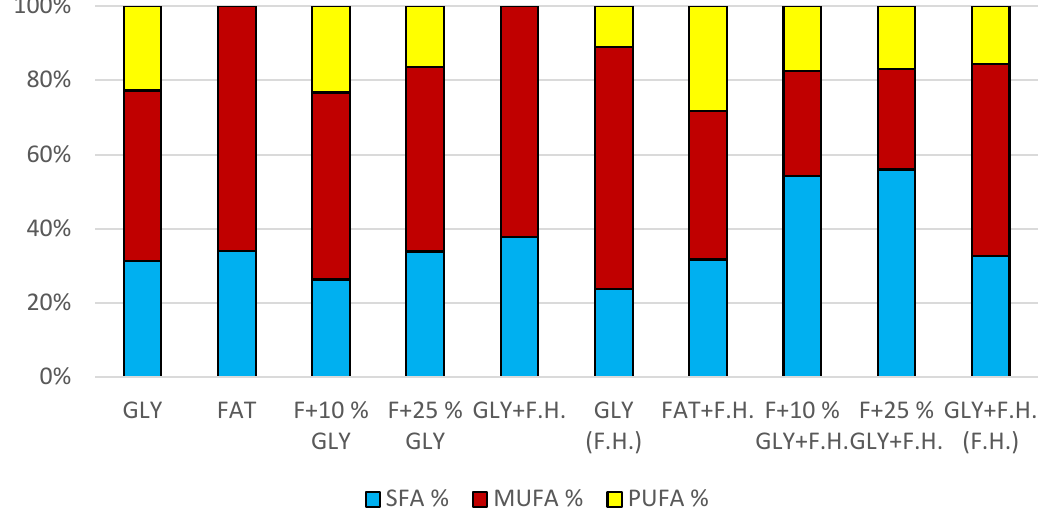
Figure 15. Fatty acid distribution in lipids of yeast strain Rhodotorula mucilaginosa in conditions of C/N ratio 50.